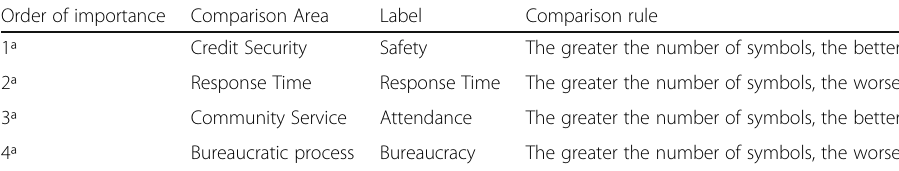
Table 3 Comparison